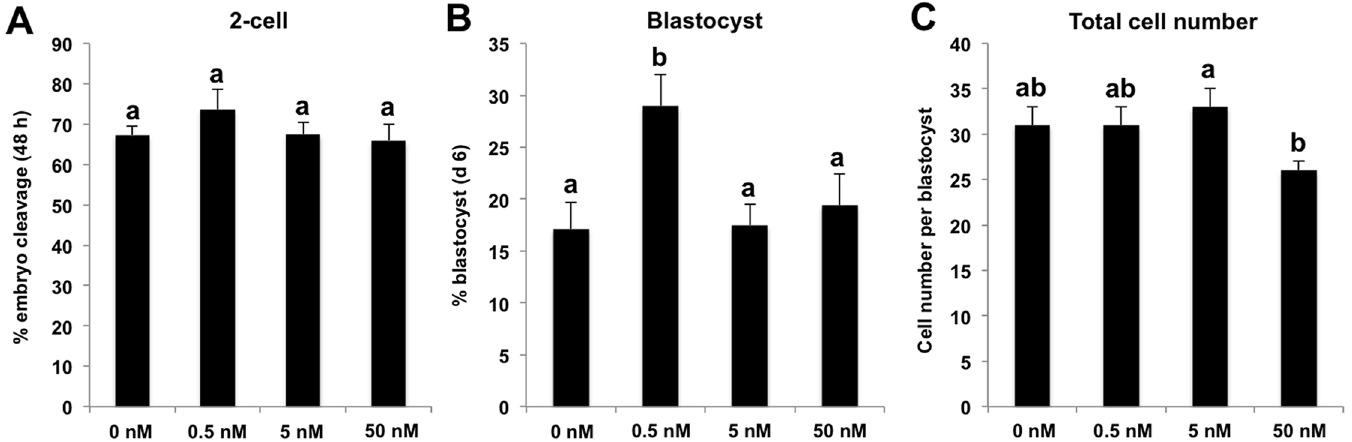
Fig 1. Effect of EPZ treatment with different dosages for 24 h on developmental competence of porcine SCNT embryos. Porcine SCNT pronuclear stage embryos were cultured in PZM-3 medium supplemented with EPZ at different concentrations, namely 0 (n = 96), 0.5 (n = 96), 5 (n = 95) and 50 nM (n = 95). The numberof 2-cell (48 h after activation, n = 64, 70, 64 and 63) (A) , blastocysts (day 6 after activation, n = 17, 28, 17 and 19) (B) and total cell numberper blastocyst (n = 17, 28, 17 and 19) (C) were recordedand statistically analyzedby SPSS software. The experimentwas repeatedfour times for each group. Data are expressedas mean ± S.E.M. Values with different superscripts across treatments indicate significantdifferences ( p < 0.05).